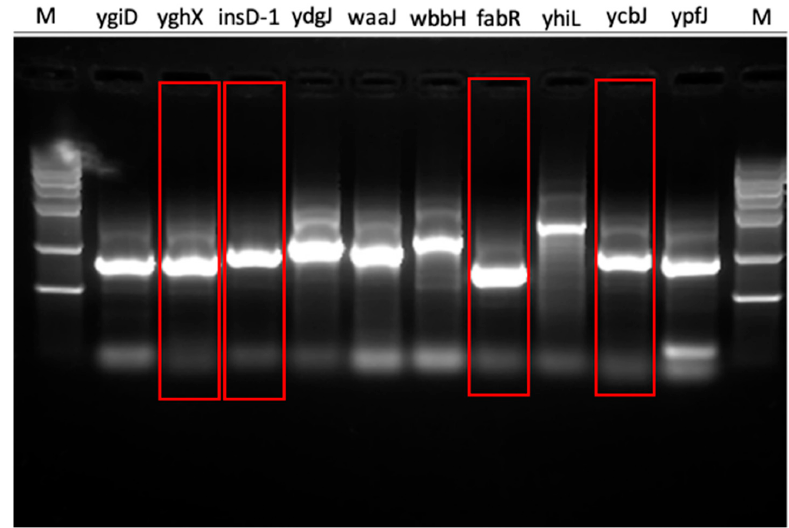
Figure 4. Experimental validation of 10 genes from E. coli . Four genes that can be easily synthe- sized are marked in red boxes. are marked in red Table 1. Comparison of our methods with SSC based on 10 genes in E. coli.